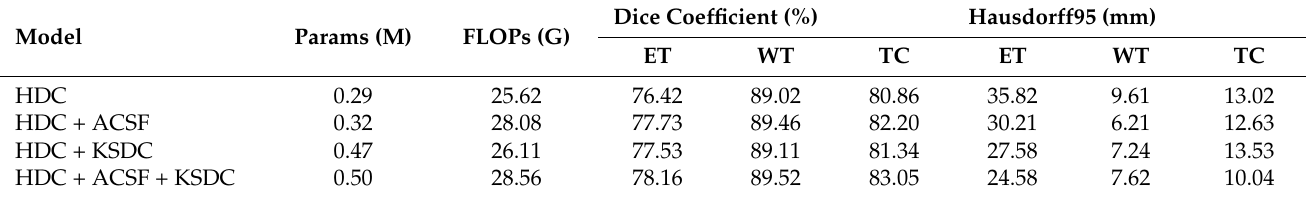
Table 3. Ablation study of the method on the BraTS 2020 validation